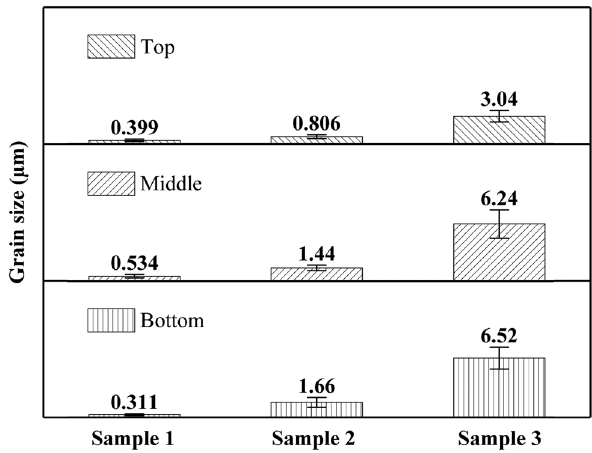
Figure 9: Grain size of di ff erent parts of each sample.